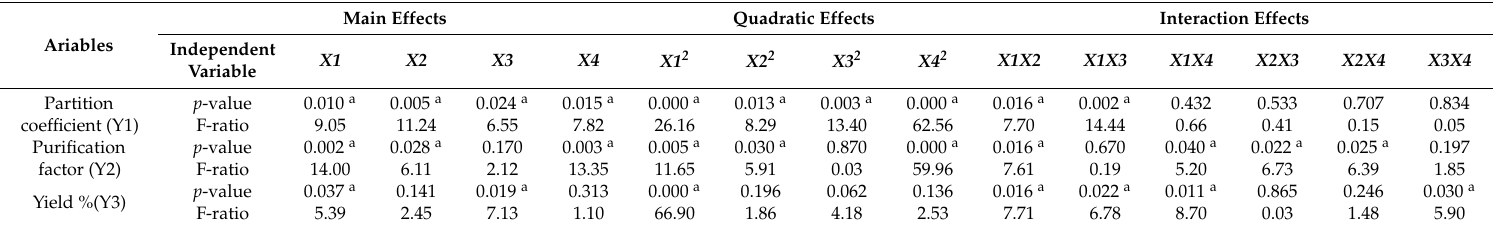
Table 2. The significance of each independent variable effect indicated by using F–ratio and p- value in the final